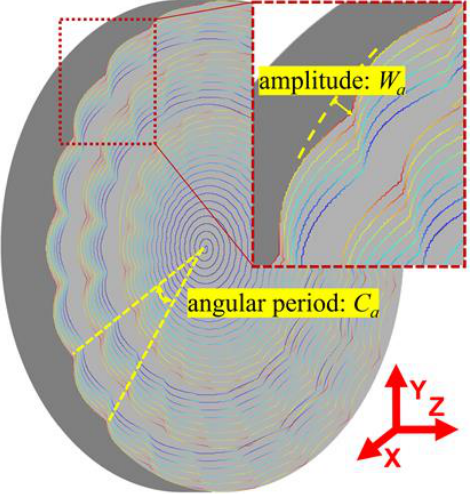
Figure 3. Generation mechanism of the surface waviness in the grinding process.